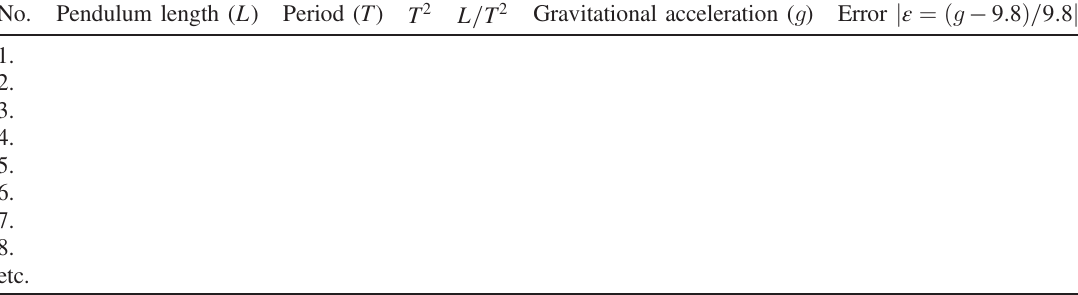
TABLE VI. Results for experiment I. No. Pendulum length ( L ) Period ( T ) T 2